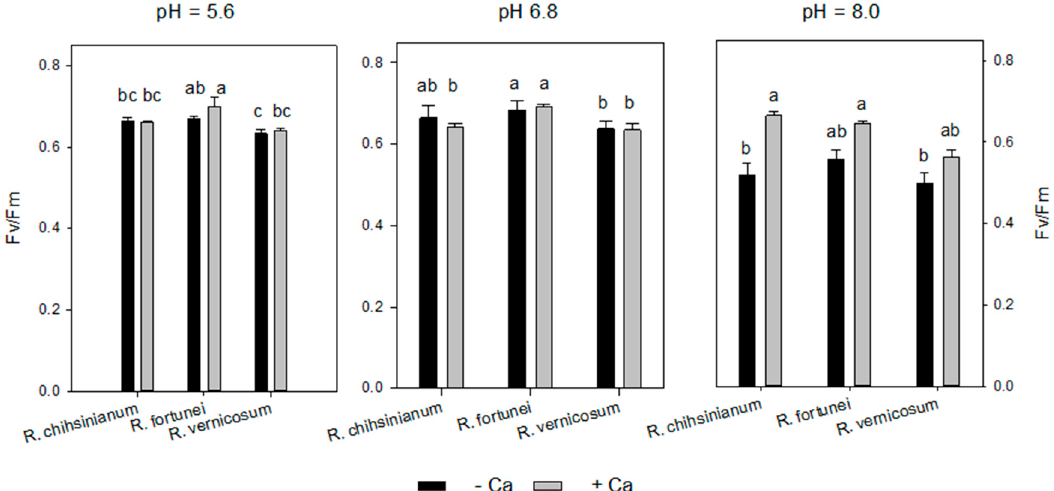
Figure 7. F v /F m of three Rhododendron sp. at different pH and additional calcium at day 41. Mean ± SE, n = 5—a,b indicate significant differences according to Tukey’s HSD test for each pH level.